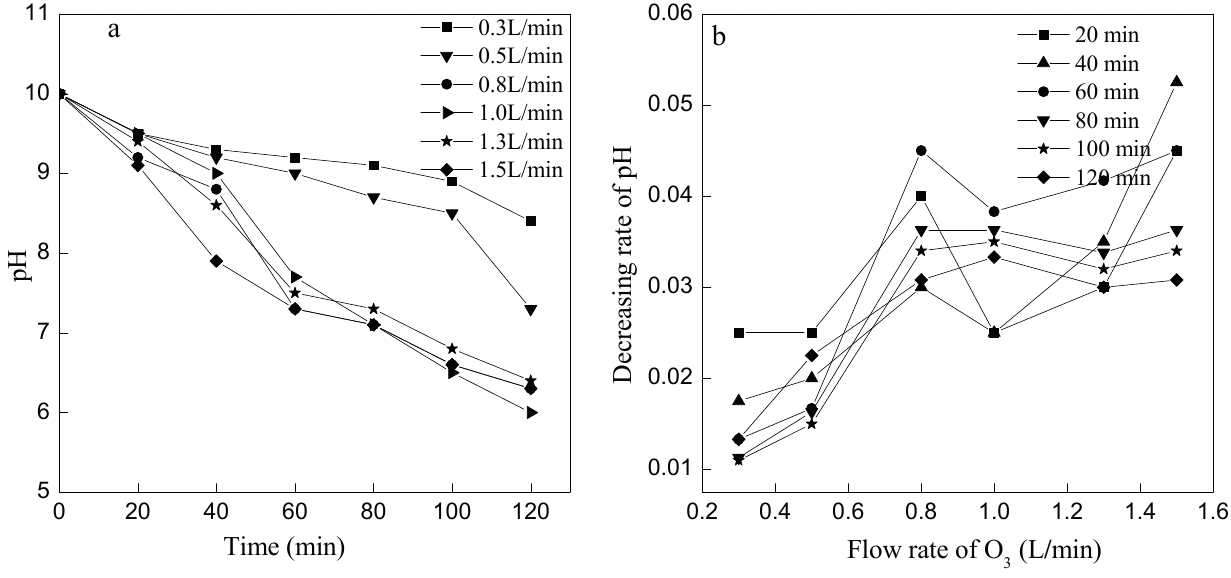
Figure 4. Variation of pH versus reaction time at different ozone flow rates. ( a ) The changes of pH at different ozone flow rate; ( b ) The decreasing rate of pH at different ozone flow